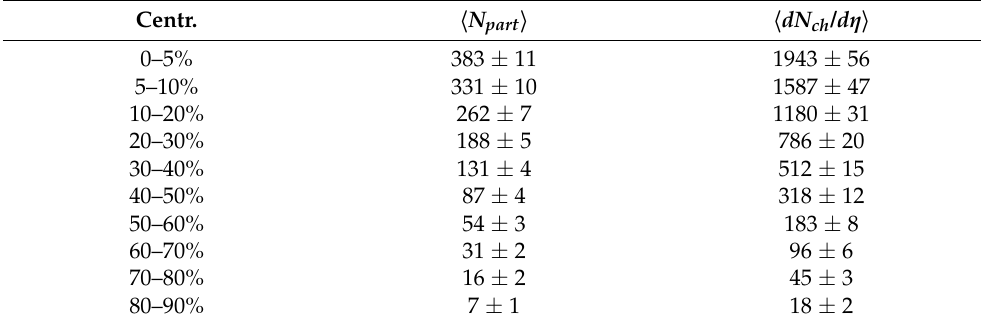
Table 1. The average number of participant nucleons and mean charged-particle multiplicity densi- ties [57,87] in the analyzed groups of centralities of Pb + Pb collisions at Centr. 〈 N part 〉 〈 dN ch / d η 〉